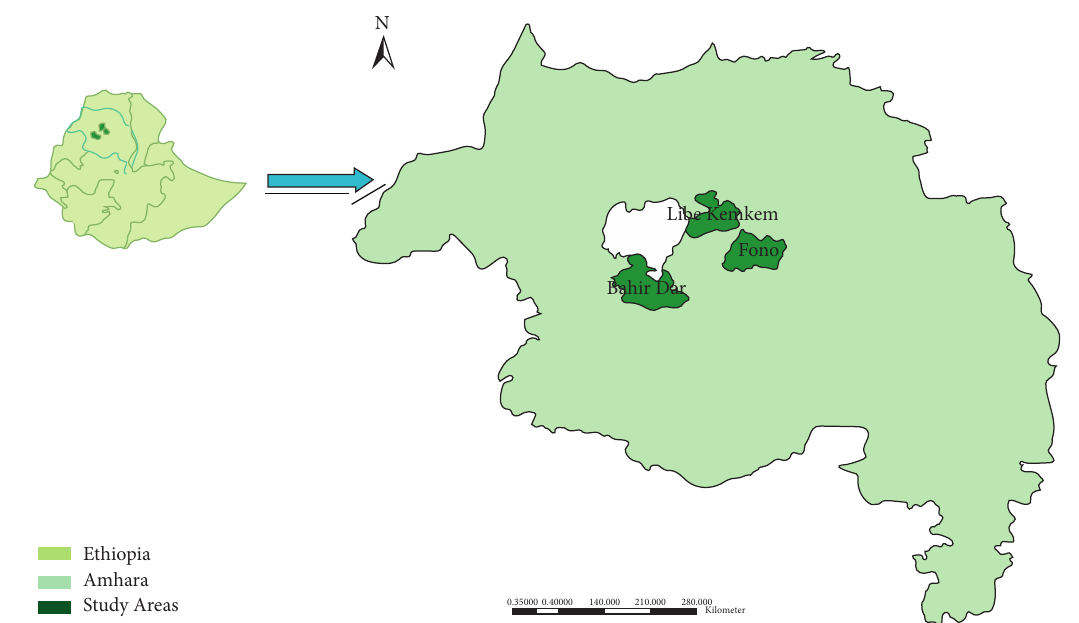
Figure 1: Map of the study area (source: Bahir Dar University, Bahir Dar, Ethiopia). Table 1: Environmental variables of study locations.